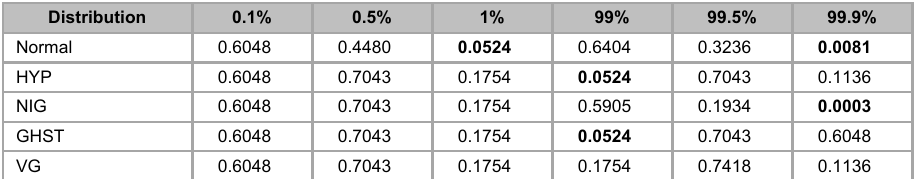
Kupiec test p -values for each distribution from one-day-ahead out-of-sample testing